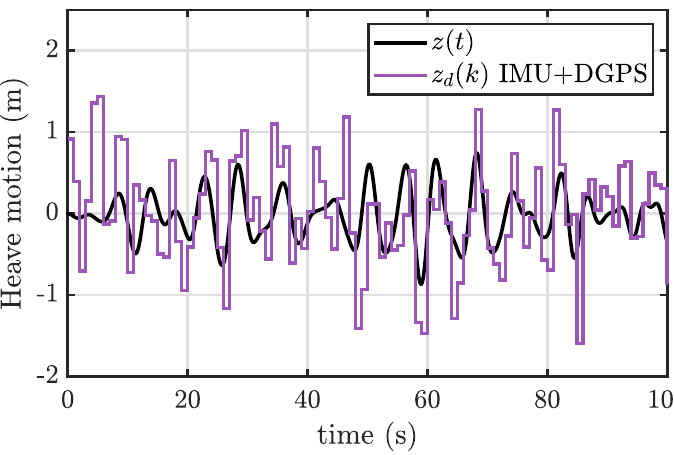
Figure 11. Heave motion compared with its DGPS acquired signal (Wave Id